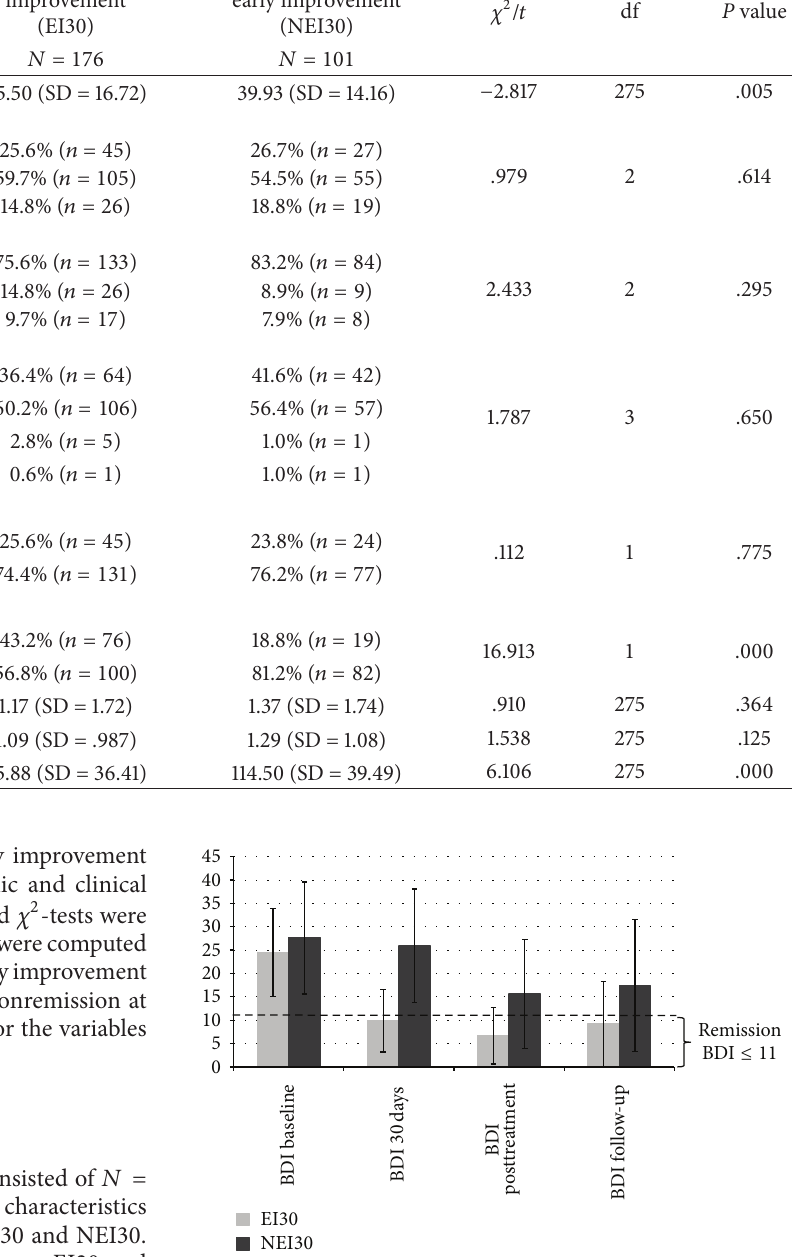
or outpatient treatments, no significant differences between significantly longer for patients in the NEI30